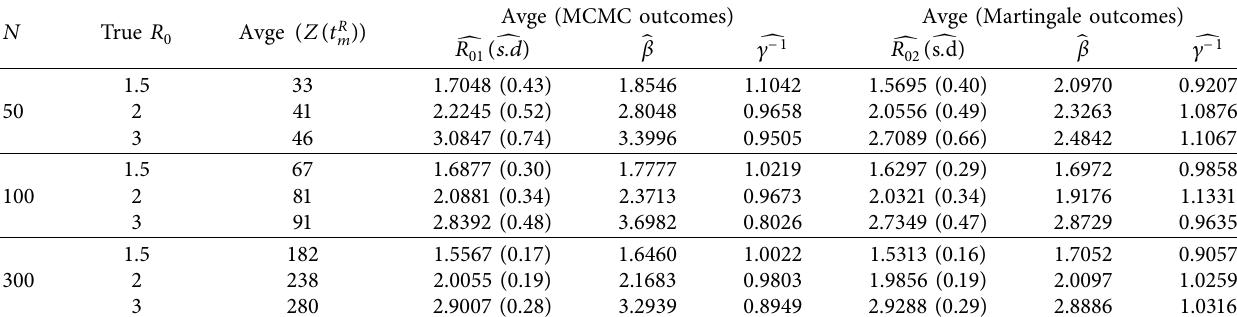
Table 2: Results of simulation study II for different values of R major outbreak